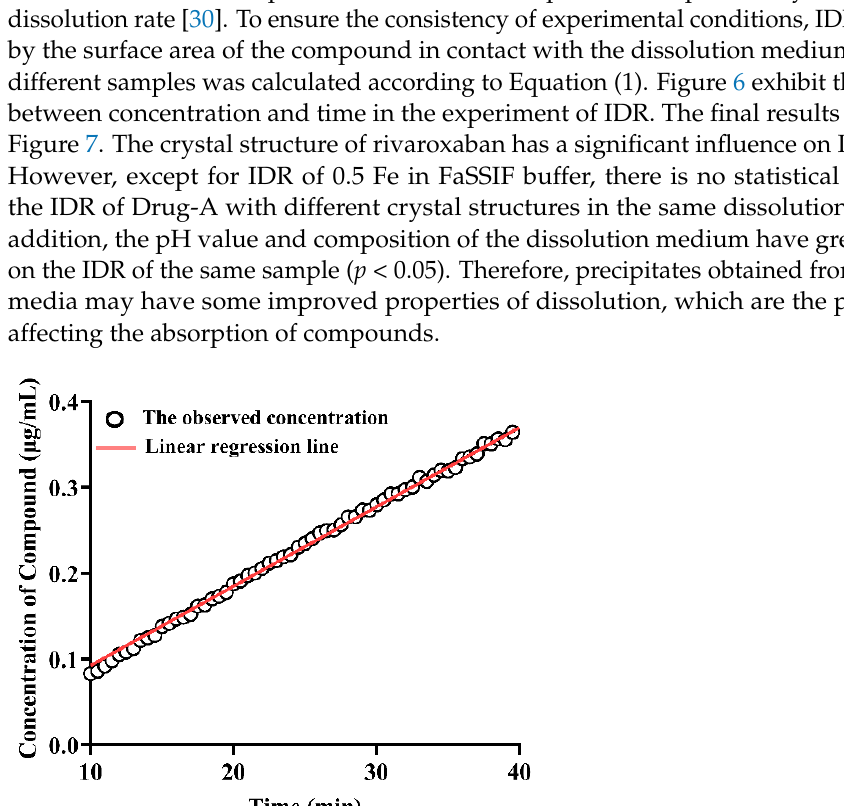
Figure 5. The dissolution profiles of different precipitates and API in the same dissolution medium. ( A ): Rivaroxaban; ( B ): Drug-A. (Fa, 0.5 Fe, Fe, and 2 Fe indicate that precipitate comes from the medium of FaSSIF, 0.5 × FeSSIF, FeSSIF, and 2 × FeSSIF, respectively).